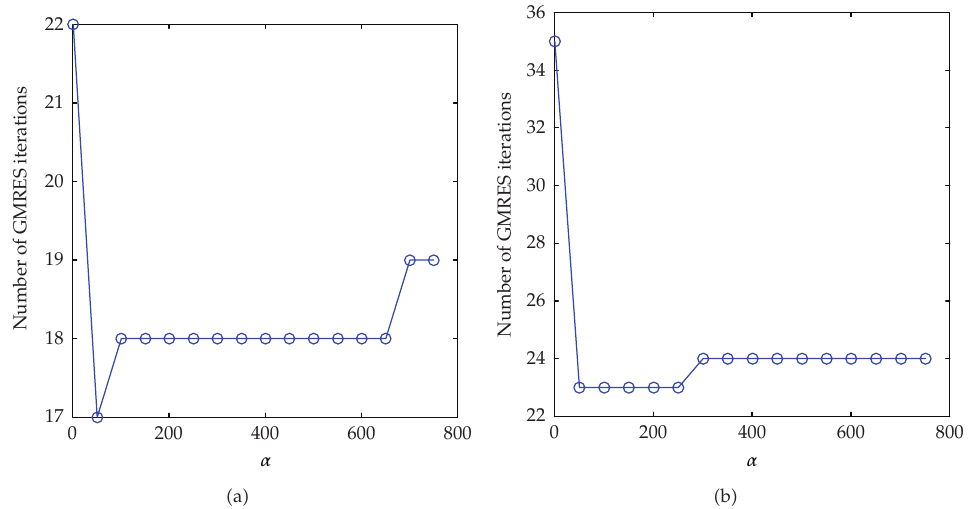
Figure 4: Iteration number versus parameter, generalized Oseen problem, with υ (cid:6) 0 . 001. (cid:4) a (cid:5) 16 × 16 grid, (cid:4) b (cid:5) 32 × 32